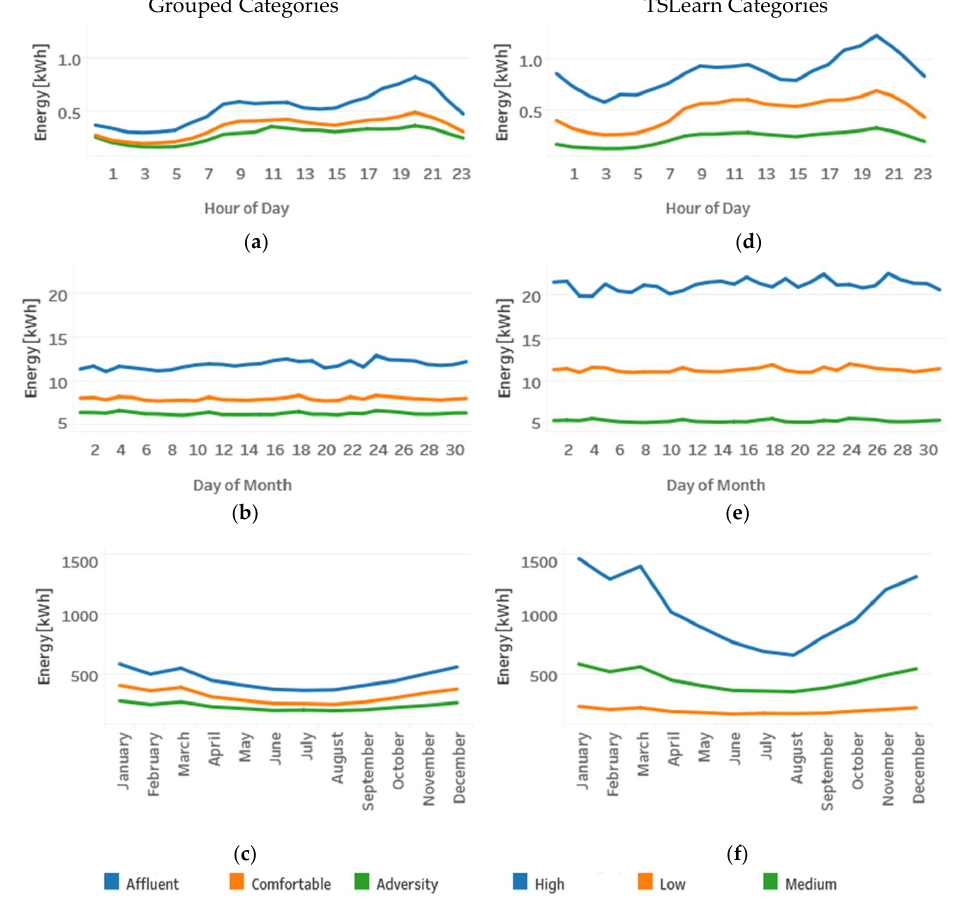
Figure 11. Energy consumption for grouped categories ( a – c ) vs. TSlearn categories ( d – f ).